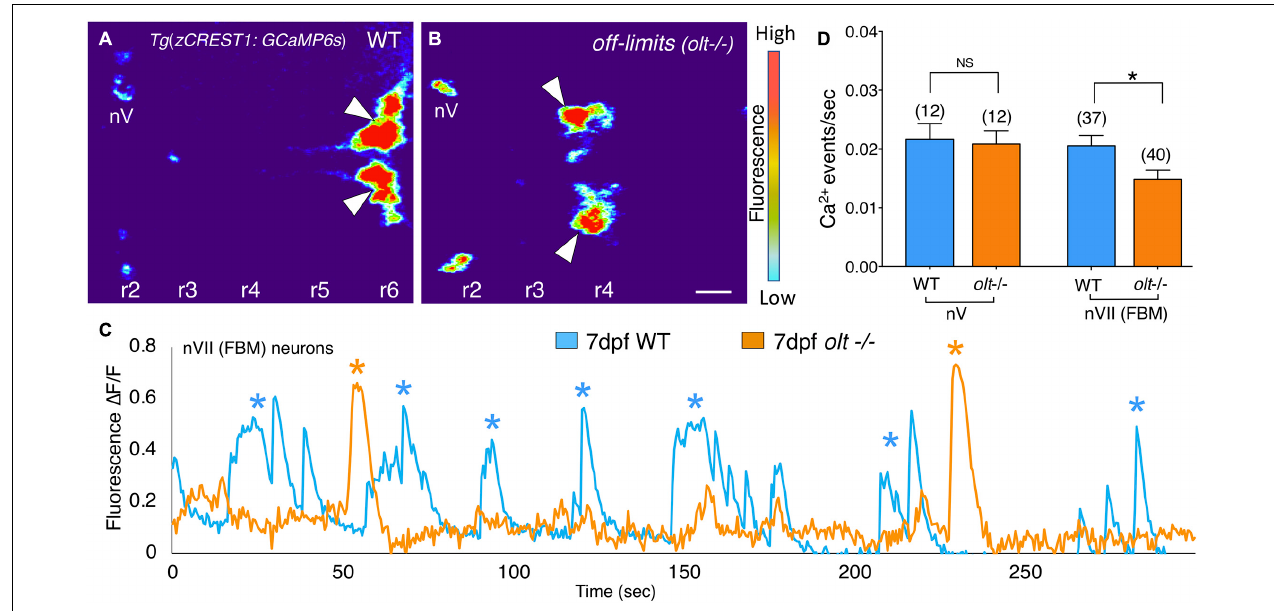
FIGURE 7 | Facial branchiomotor neurons are less active in olt mutants. (A,B) Dorsal views, with anterior to the left, of the hindbrains of 7 dpf Tg ( zCREST1:GCaMP6s ) ;TgzCREST1:mRFP larvae showing GCaMP fluorescence intensities. (A) In a wildtype larva, fluorescence can be seen in the FBM neurons (arrowheads) in r6, as well as the trigeminal motor neurons (nV) in r2. (B) In an olt mutant, fluorescence is evident in the nV neurons in r2 and in the FBM neurons (arrowheads) that have failed to migrate out of r4. (C) Overlay of GCaMP6s (cid:49) F / F traces for a representative wildtype sibling (blue) and an olt mutant (orange) showing fewer Ca 2 + events (asterisks) in the mutant. Amplitudes of the Ca 2 + events were not affected. (D) The frequency of Ca 2 + events in FBM neurons was significantly lower in olt mutants compared to wildtype siblings. The Ca 2 + event frequency for trigeminal motor (nV) neurons was not affected in mutants. Data pooled from 6 experiments (number of larvae in parenthesis). The two-tailed student t -test was performed to test for significance, * p <